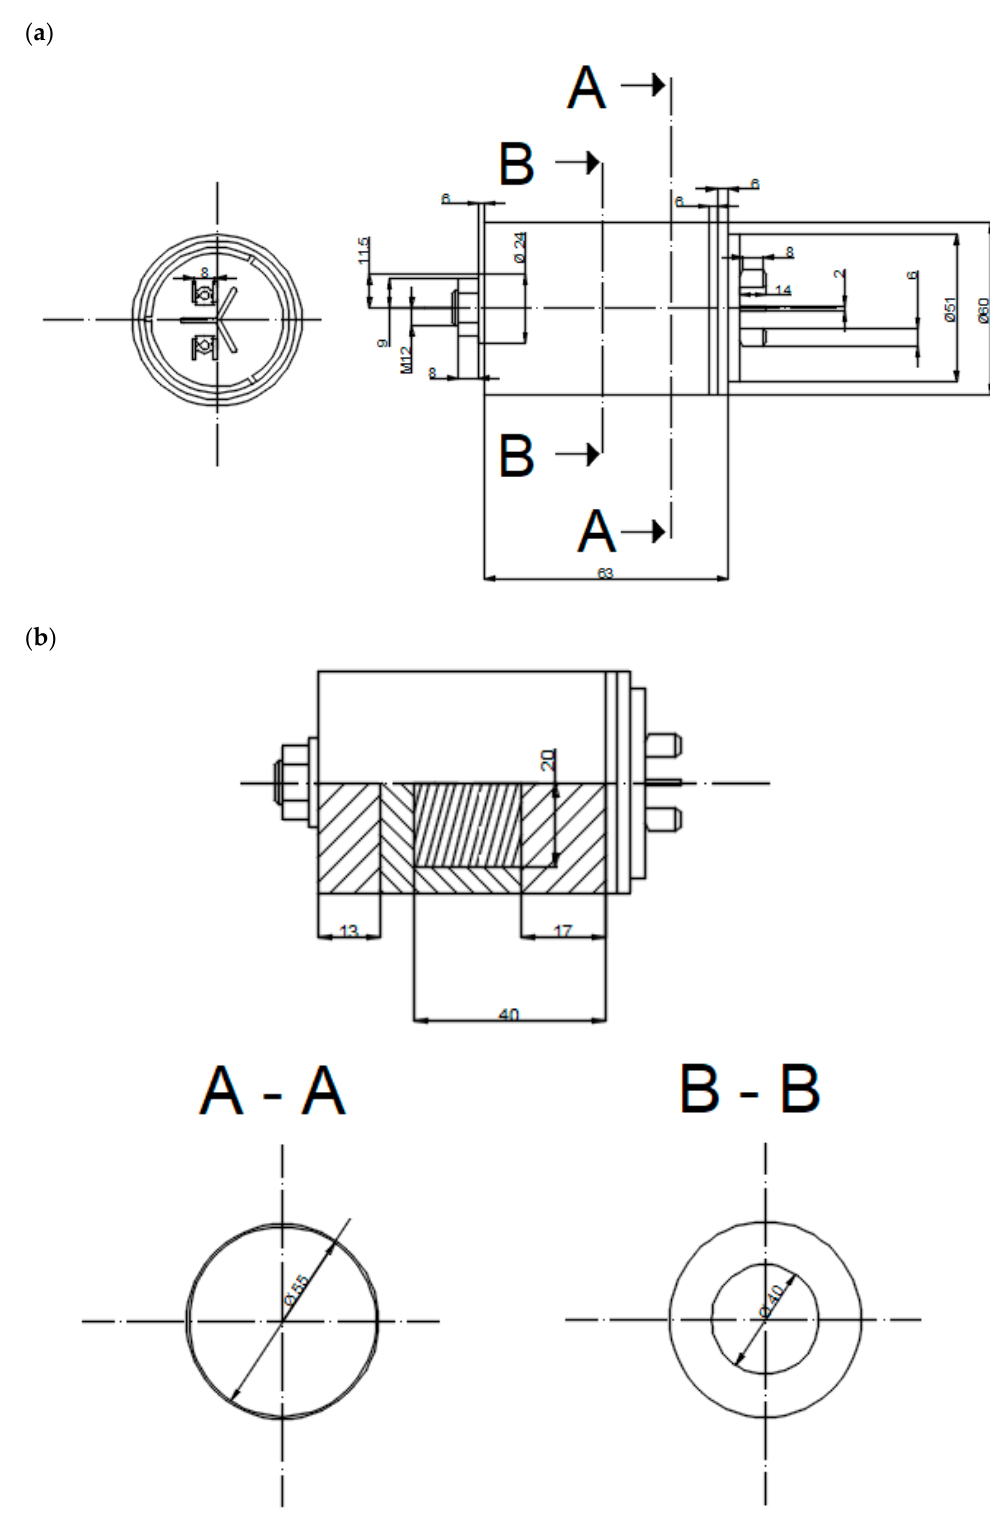
Figure 2. ( a ) External dimensions of the capacitor used, and ( b ) internal dimensions.